Question: Based on the figure, does the quantity rise or fall?
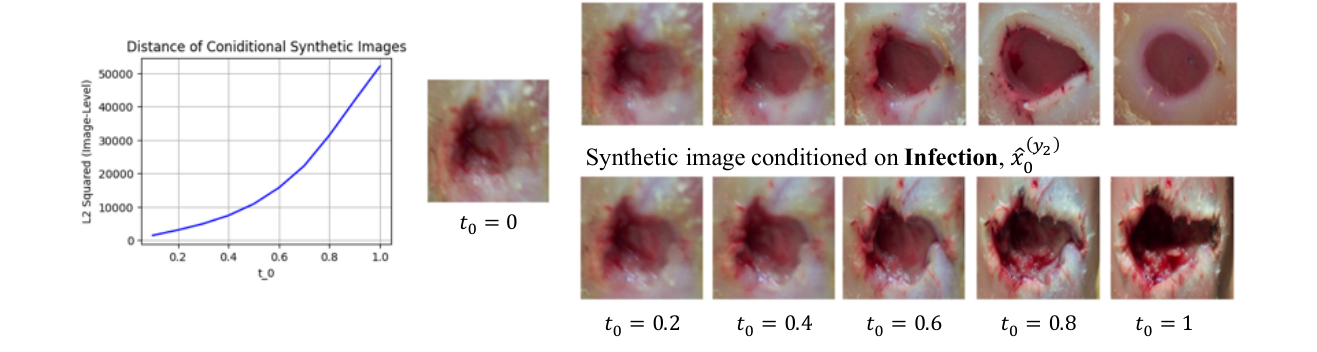
Answer: increasing